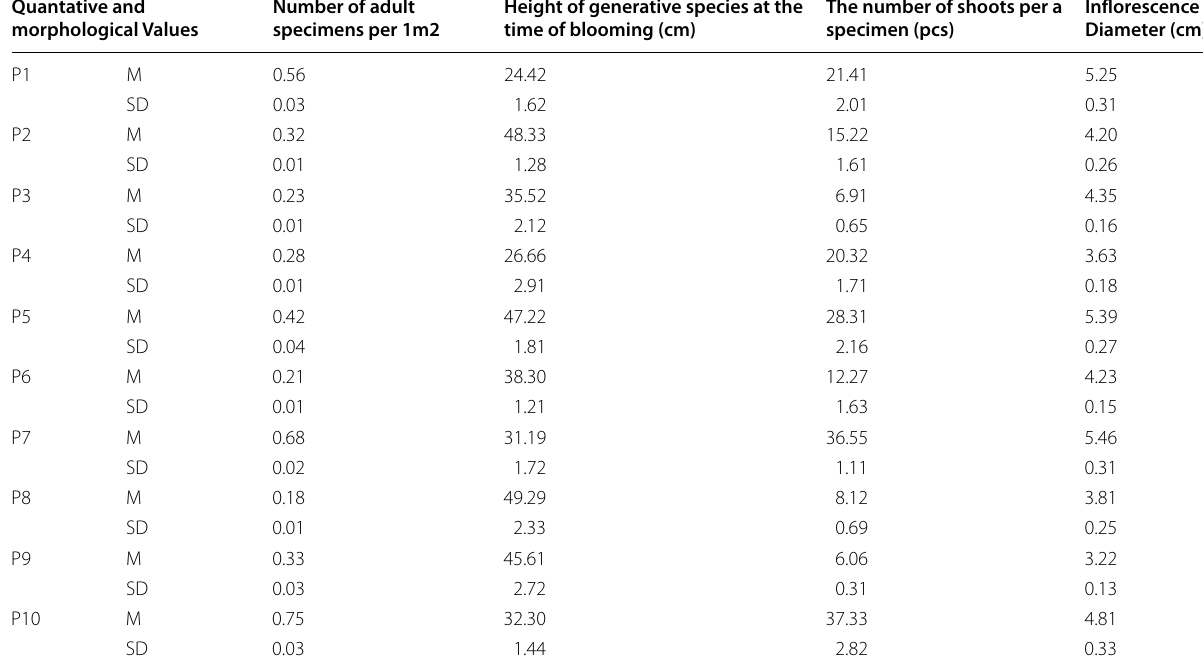
Table 1 Quantitative and morphological indicators of R. rosea specimens from the study plots P1–P10 Quantative and morphological Values